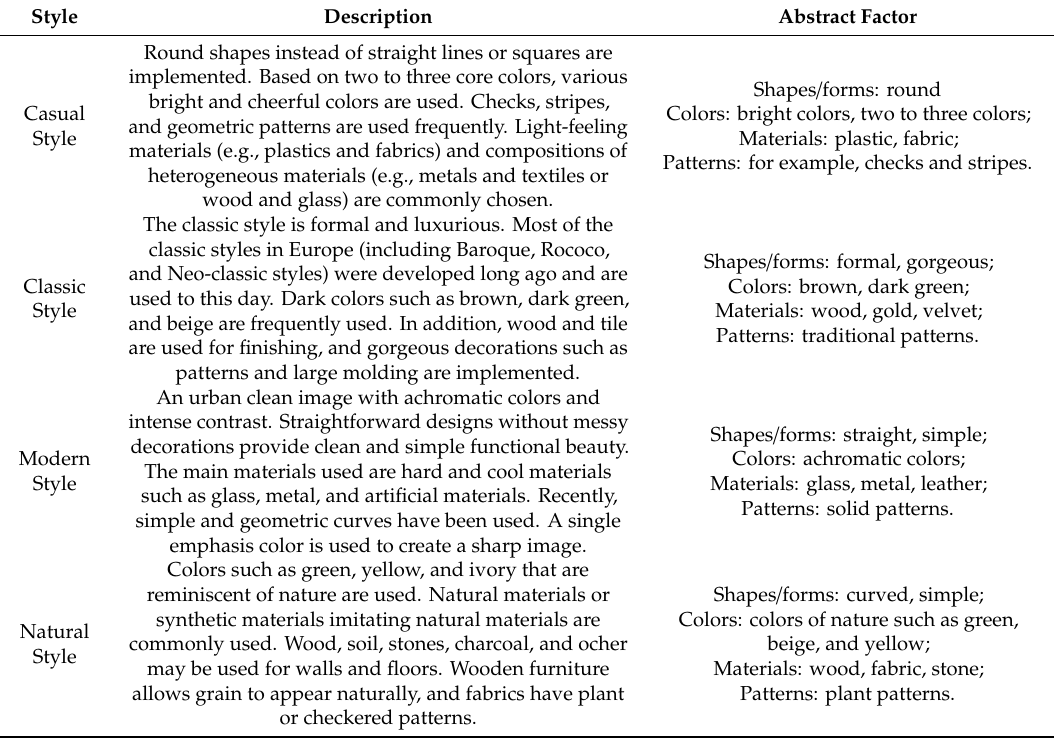
Table 3. General definitions of interior design styles derived from previous research